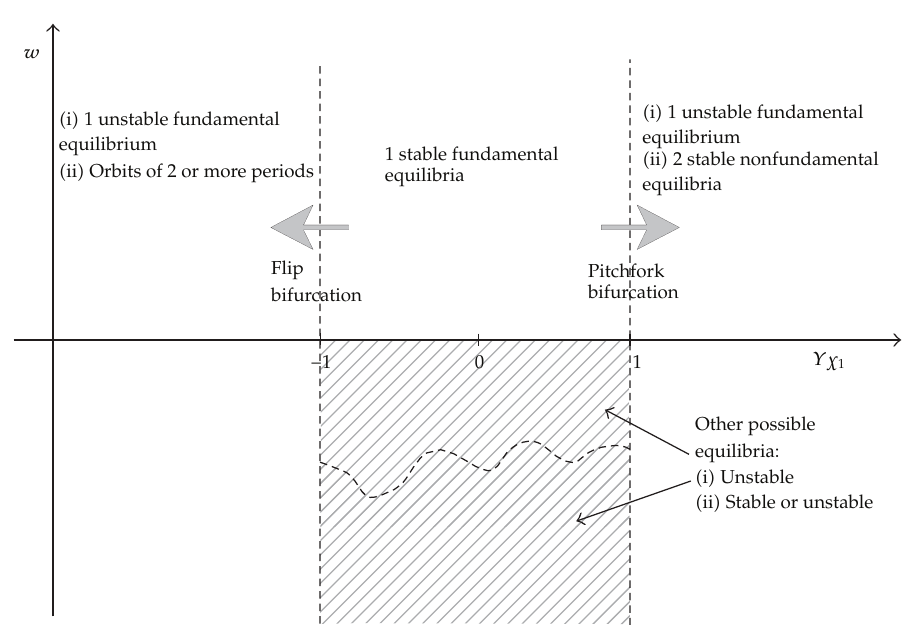
Figure 10: Diagram of stable/unstable equilibria (cid:3) mixed rational and speculator (cid:6)